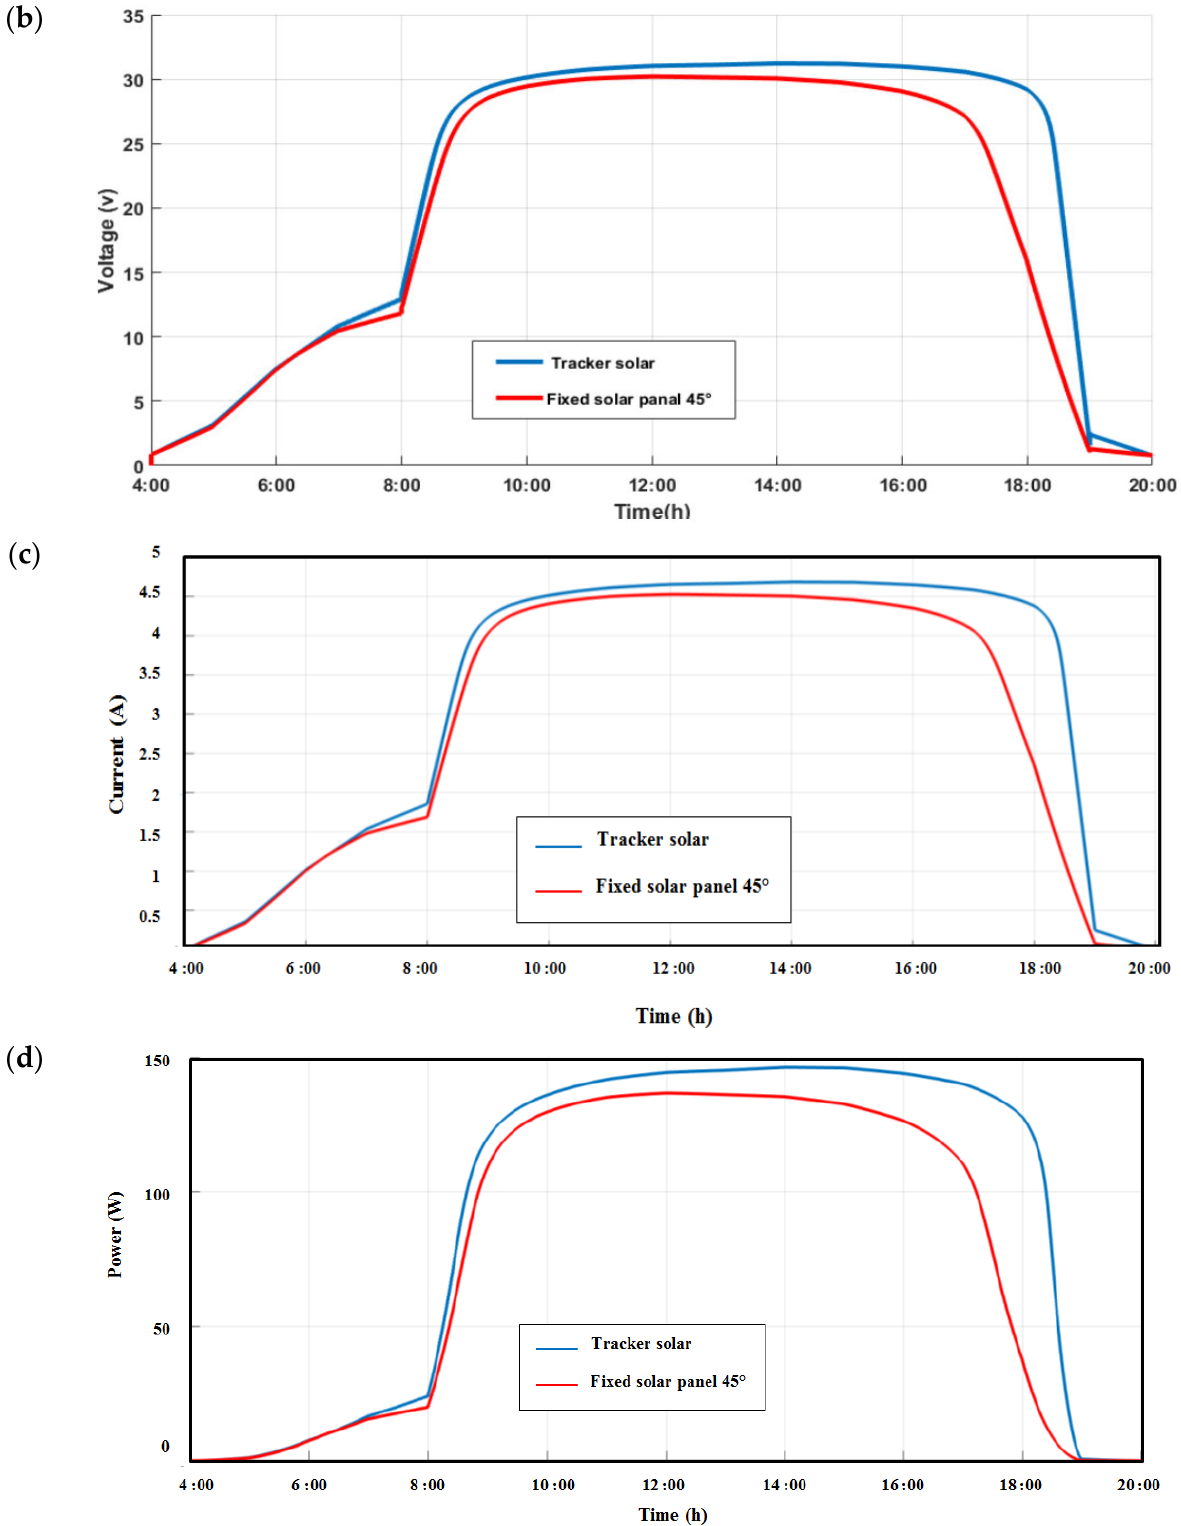
Figure 16. Values of ( a ) solar radiation, ( b ) voltage, ( c ) current, and ( d ) power produced by a PV panel bound with a solar tracker compared to a fixed PV panel.